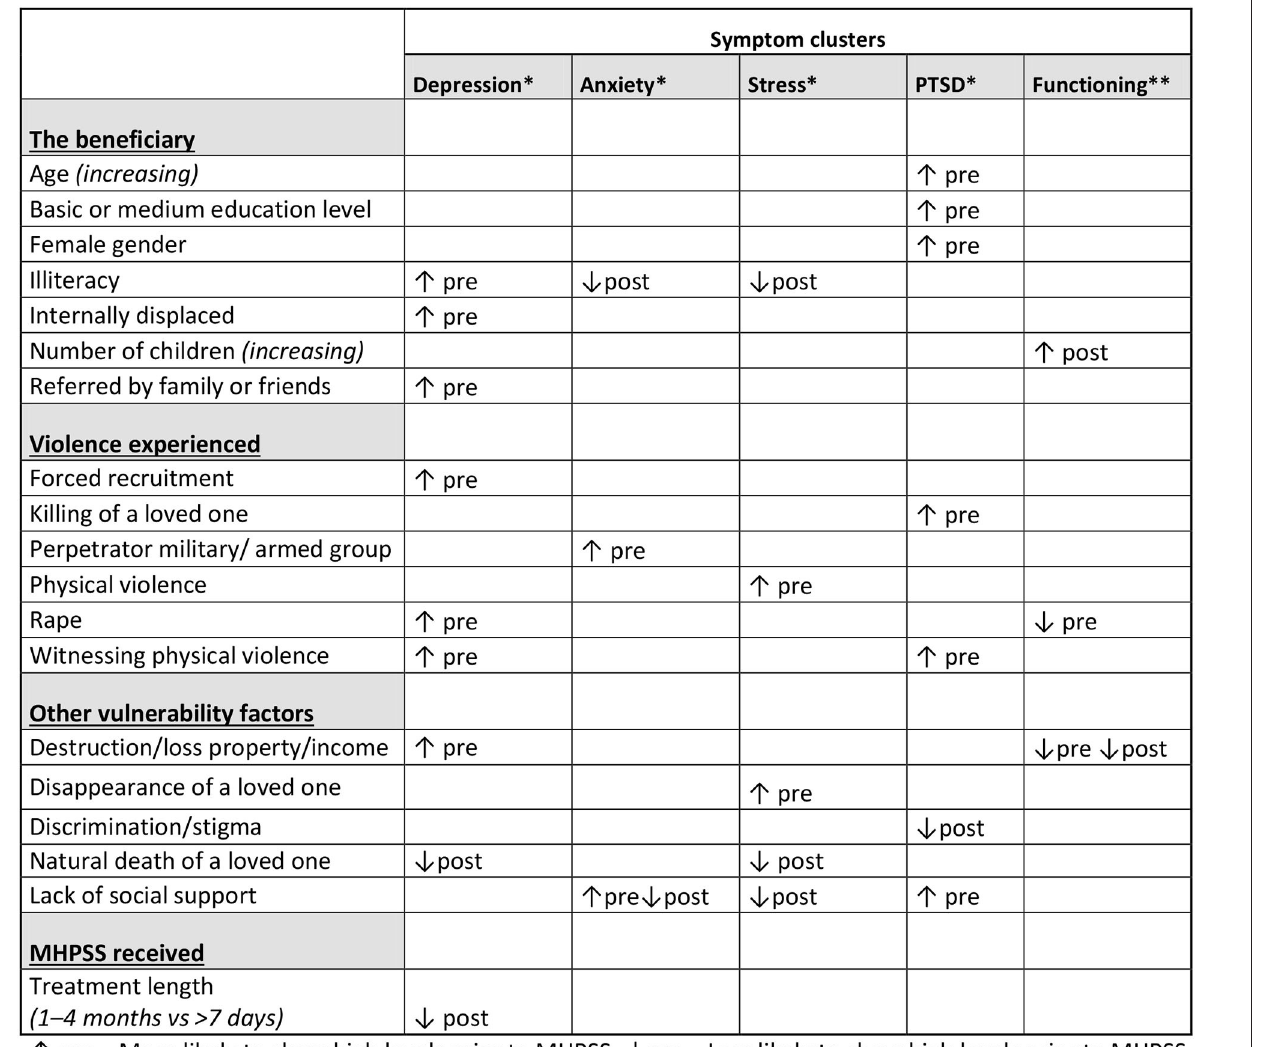
FIGURE 4 | Summary of the main